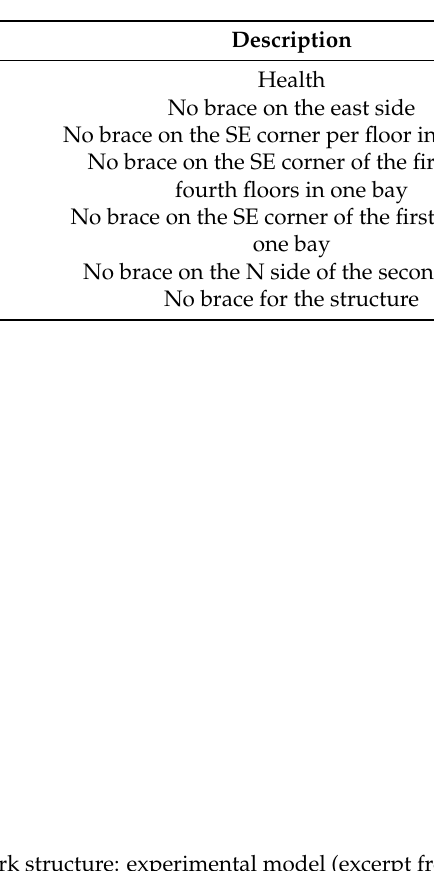
Table 1. Dataset 1: First benchmark structural cases.